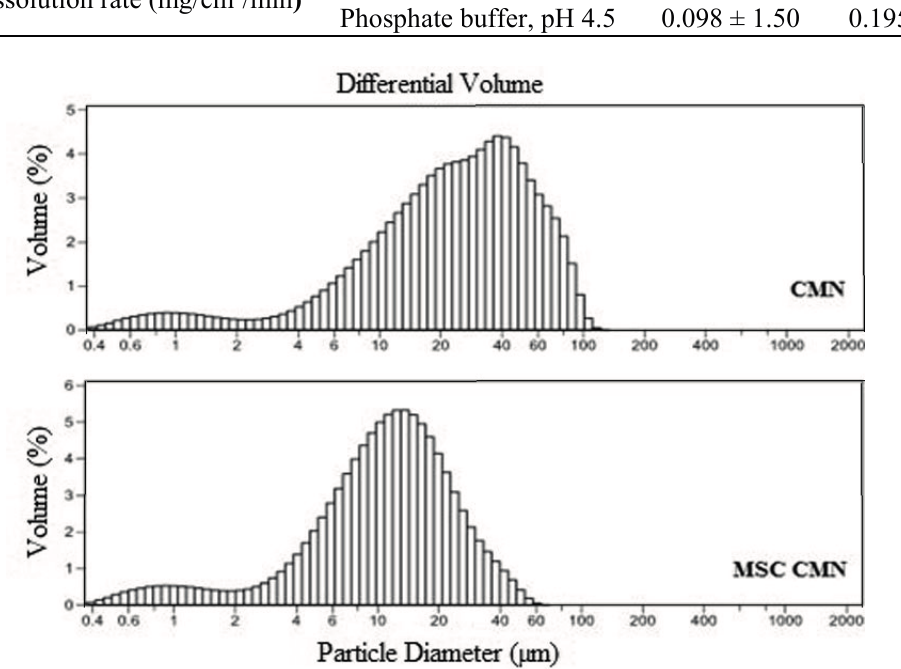
Figure 1. Frequency distribution curves of CMN and MSC